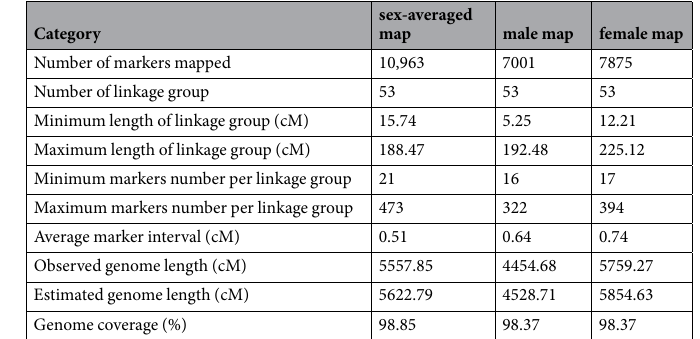
Table 4. Summary of Portunus trituberculatus linkage